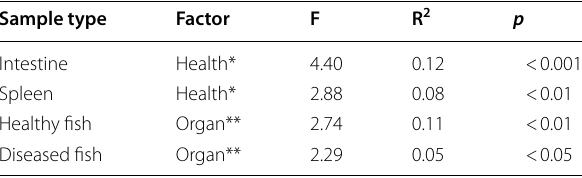
PERMANOVA tests demonstrated that there were significant differences between the microbiota compositions of the two organs in the same fish health condition and between the same organ in the healthy and the diseased fish (See also Fig. 1) *Healthy versus diseased. **Intestine versus